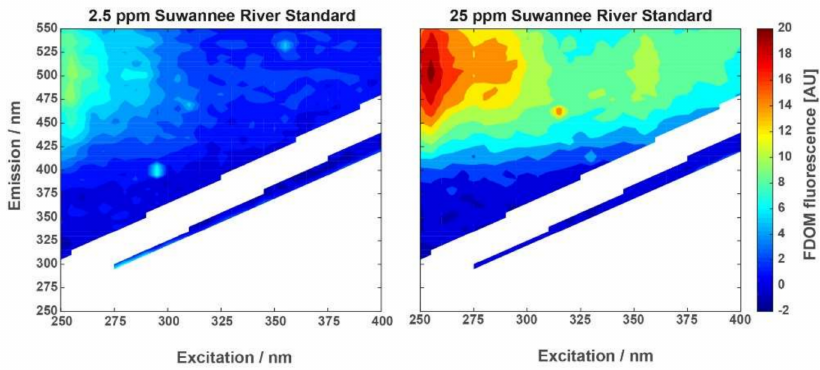
Figure 5. EEM spectra for two concentrations of Suwannee River standard. Excitation wavelengths were used for the x-axis, while emission wavelengths were applied for the y-axis [42]. Color bar (z-axis) denotes relative fluorescence